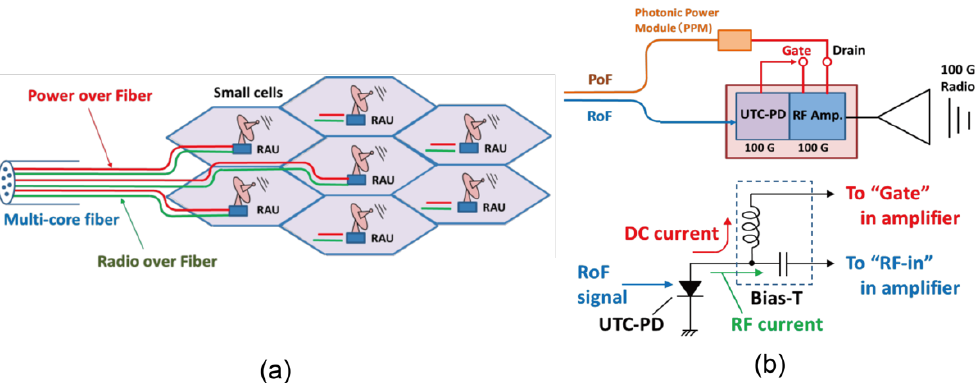
Figure 7. ( a ) Configuration of mobile communication network with optically powered RAUs using an MCF. ( b ) Schematic view of ORC module (upper) and detailed circuit diagram (lower) [43].